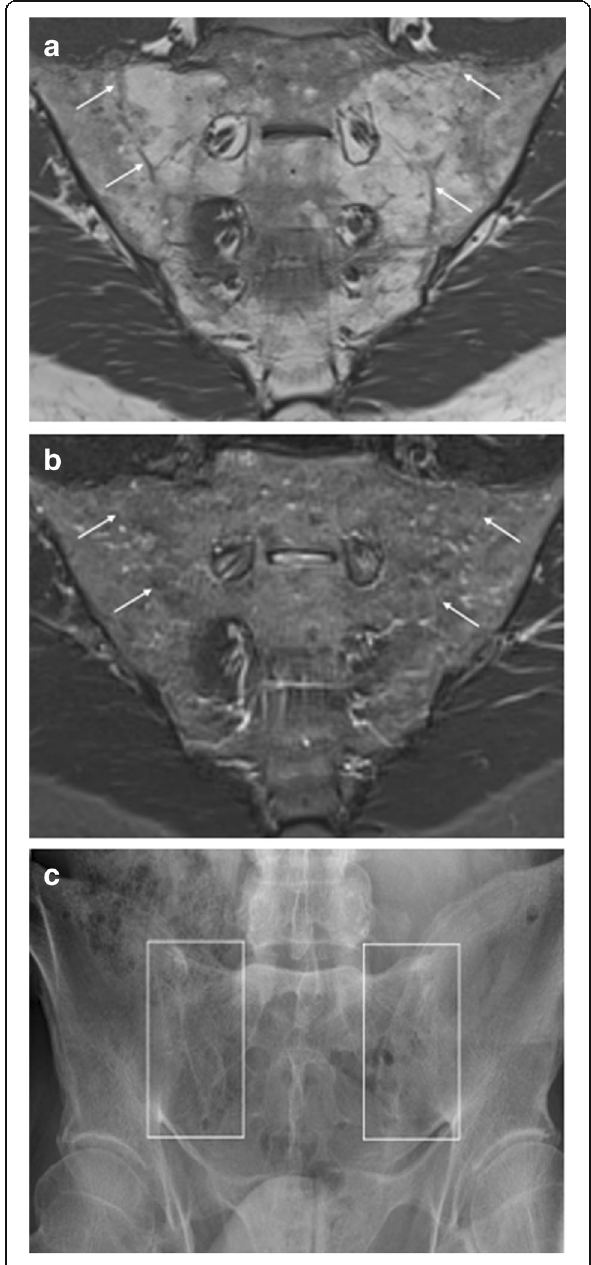
Fig. 3 Ankylosis of the sacroiliac joints. Coronal oblique MR images acquired in a 53-year-old man with SpA show bony fusion of the sacroiliac joints as ( a ) high signal intensity on T1-weighted imaging (fatty degeneration) and ( b ) low signal intensity on STIR imaging. A sclerotic remnant of the sacroiliac joints is highlighted